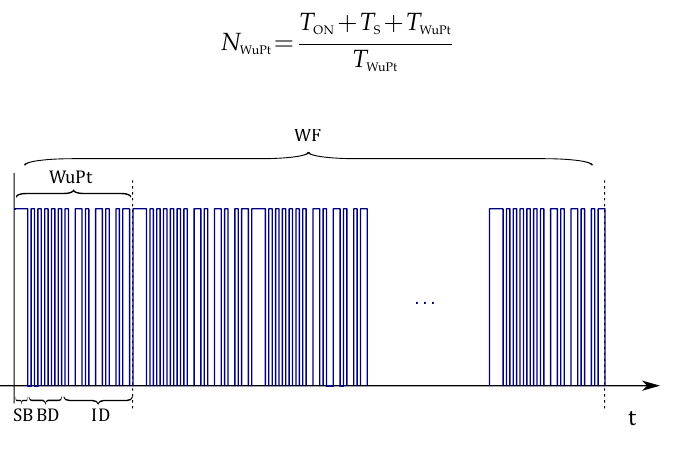
Figure 11. Wake-up frame structure. WF, wake-up